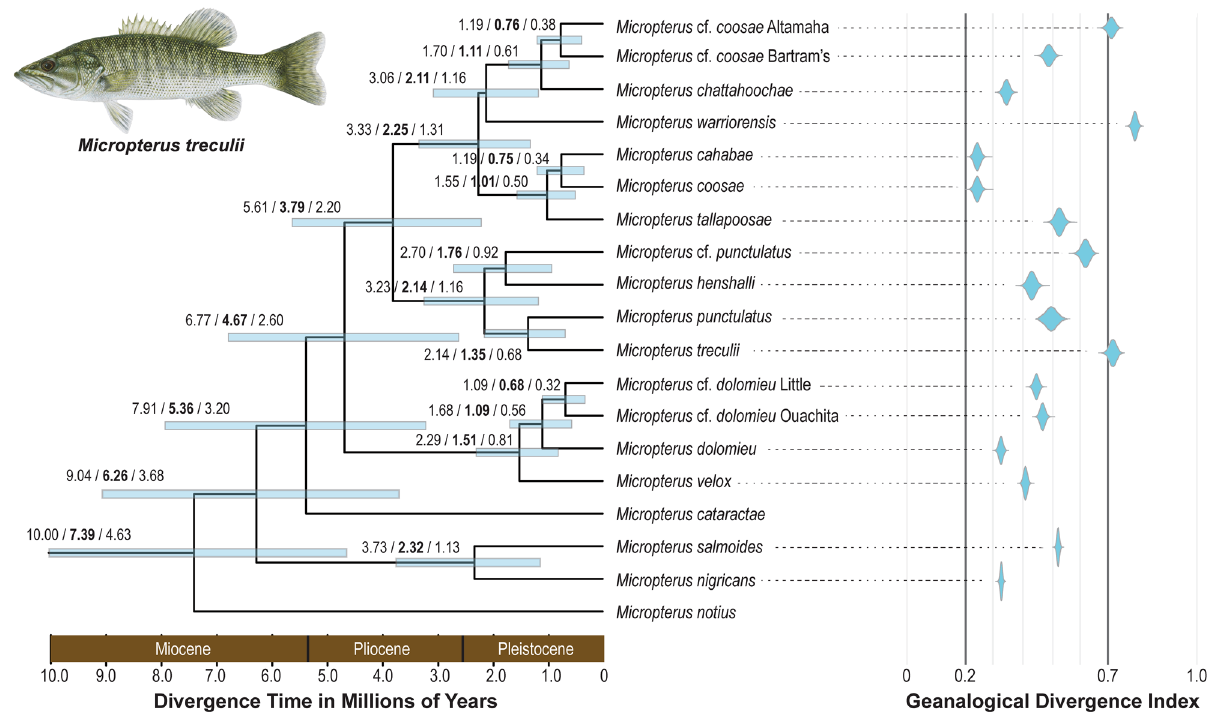
Figure 4. Time-calibrated species tree for Micropterus , inferred from SVDQuartets and BEAST2. All nodes have bootstrap supports of 100%, except the node leading to M. cataractae and the Smallmouth, Spotted, and Redeye Bass complexes, to M. warriorensis , M. chattahoochae , and the undescribed Altamaha and Bartram’s basses, and to M. cahabae and M. coosae . Numbers at nodes indicate a mean and 95% highest posterior density (also depicted with light blue bars) of relaxed molecular clock divergence times. Violin plots for genealogical divergence index ( gdi ) of species delimitations are aligned with and shown on the right of species tree. Illustration © Joseph R. Tomelleri, used with permission.